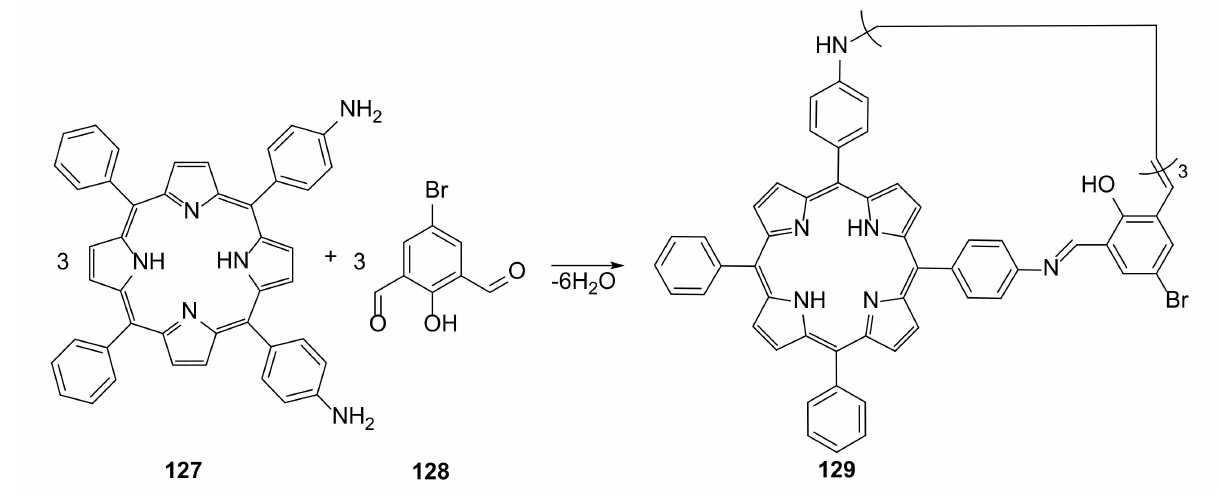
Figure 23. One-pot synthesis of conical phorphiryn macrocycle 129 .